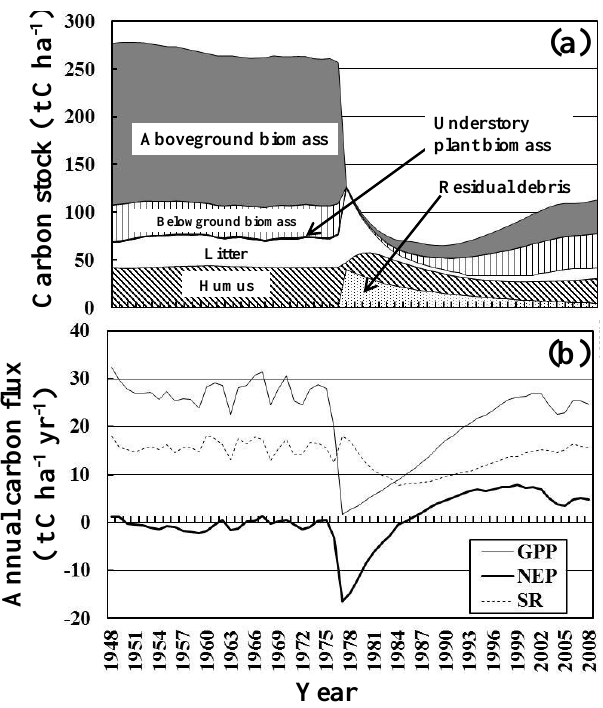
Fig. 7. Temporal variation in C stock (a) and C flux (b) within the rainforest (RF) during 1948–2008, including land-use conver- sion from a primary forest to oil palm plantation in 1976. The sub- classes of C stock are aboveground biomass of canopy tree (gray), belowground biomass (vertical), understory plant biomass (black), dead biomass and detritus (litter; white), humus (diagonal line), and residual debris (dotted) from top to bottom. The subclasses of C flux are gross primary production (GPP; solid line), soil respiration (SR; broken line) and net primary production (NEP; bold